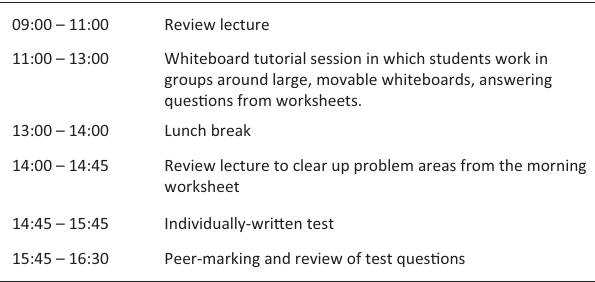
FIGURE 1: Daily structure of the mathematics tutored reassessment